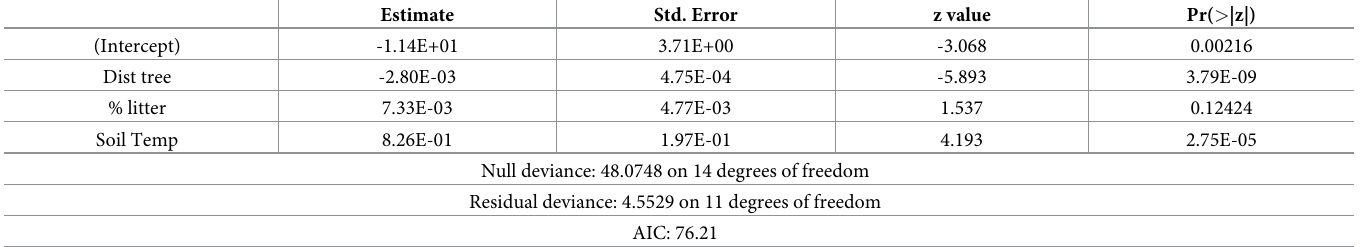
Table 3. Statistics of the Generalized Linear Model (GLM) used to assess the relationship between the explanatory variables [DBH, tree height, distance between trees, DAH, shrub height, distance between shrubs, percentage of litter; green cover, bare soil, depth of litter, clay, sand, lime, moisture] and the taxonomic richness. Estimate Std.